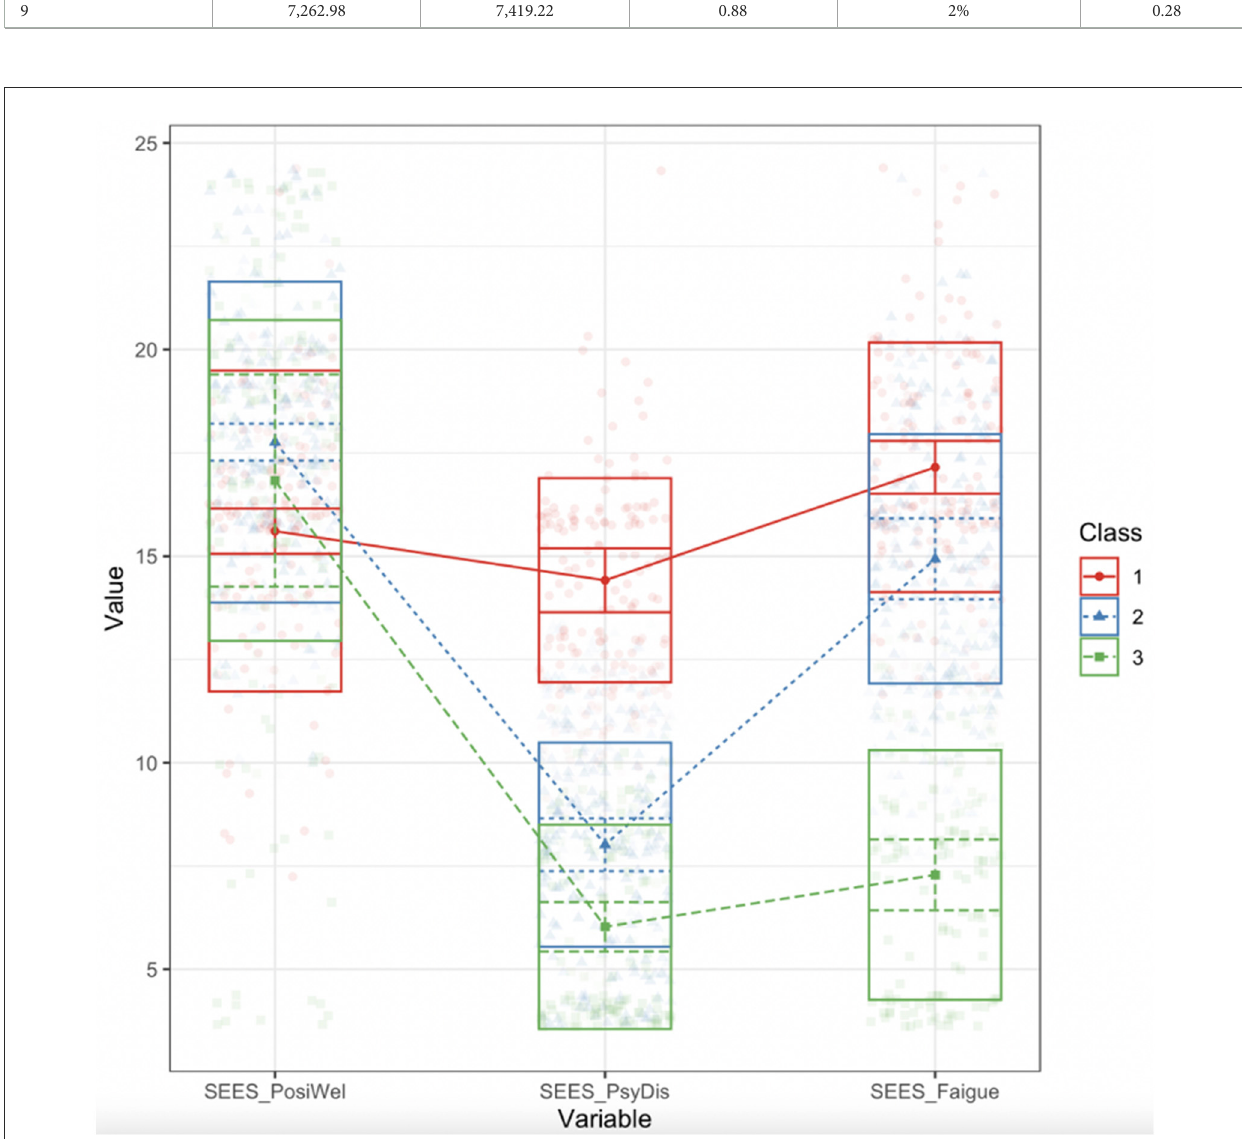
FIGURE1 The mean factor score of the subjective exercise experience (SEES) by class. PosiWel: Psychological wellbeing. Fatigue: Psychological fatigue. PsyDis: Psychological distress. Class 1 was the “negative experience group” characterized by low positive wellbeing, high psychological distress, and high psychological fatigue. Class 2 was the “fatigue” group characterized by high positive wellbeing, low psychological distress, and high psychological fatigue. Class 3 was the “positive experience group” characterized by high positive wellbeing, low psychological distress, and low psychological